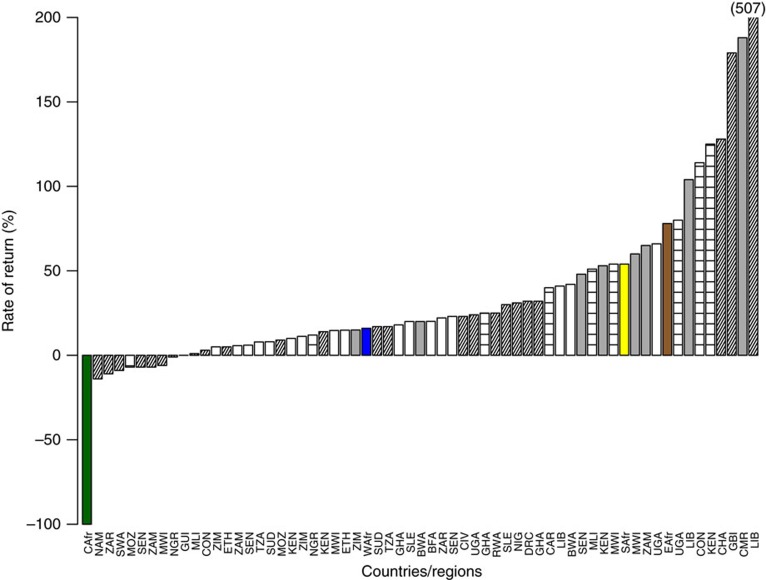
Comparing rates of return in African elephant conservation to other investments.Mean rates of return to tourism from investing in efforts to reduce elephant poaching in central (green), west (blue), southern (yellow) and east (brown) Africa, along with a sample of rates of return estimated for investments in education (white bars24), agriculture (grey bars25), electricity (horizontal cross-hatched bars26) and infrastructure (angled cross-hatched bars26) in 33 African elephant range state countries (country abbreviations on bottom axis of figure).